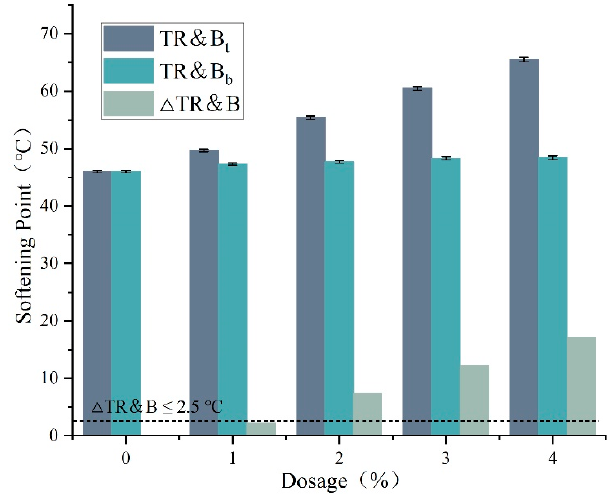
Figure 6. Softening point of DM-modified asphalt after thermal storage.